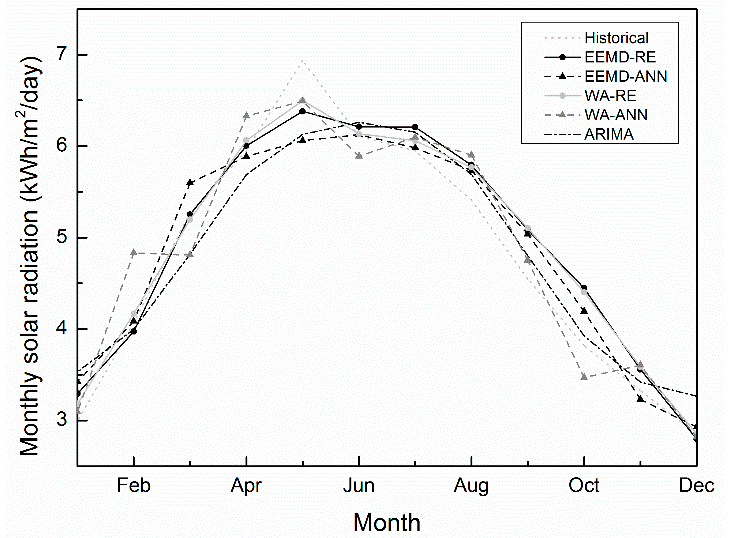
Figure 5. Predictive solar radiation results of the year 1995 using monthly data.